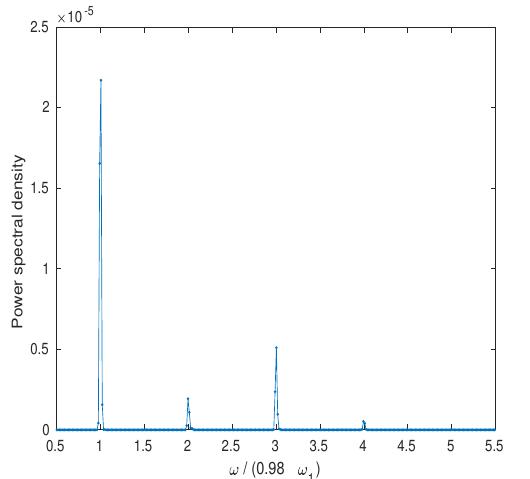
Figure 15. The frequency spectrum of coupled surge − sway − roll − pitch excitations cases at the tank corner under different excitation frequencies. Excitation frequency is 0.98 ω 1 .